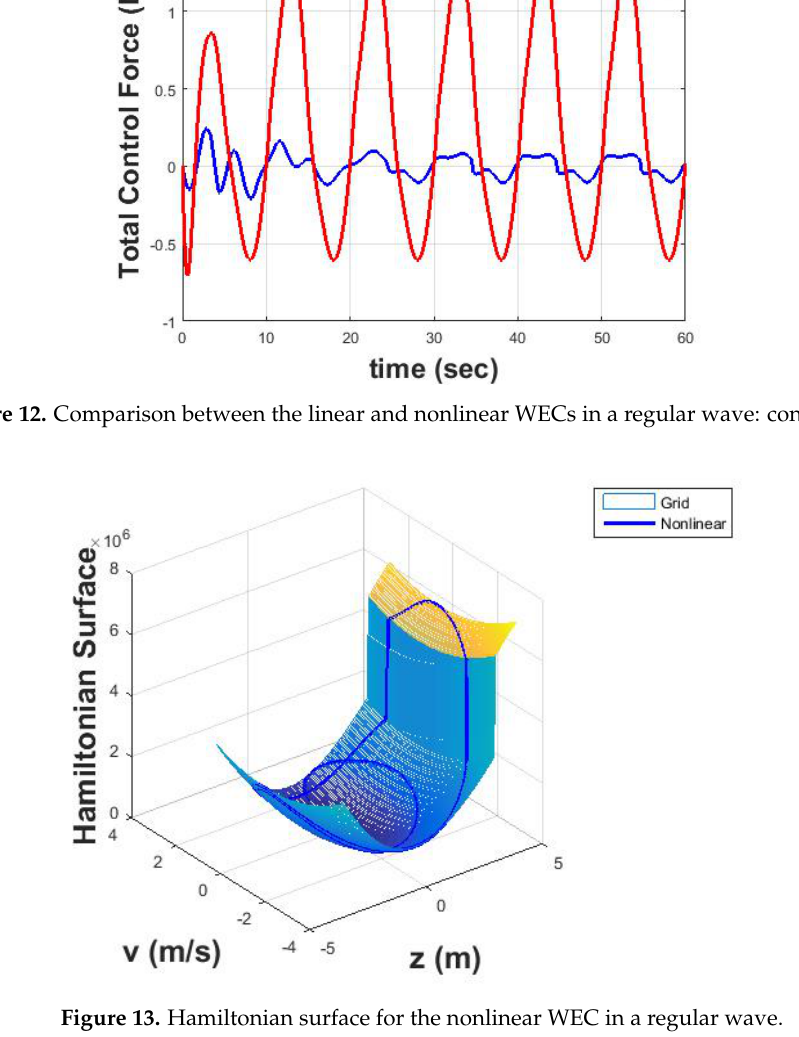
Figure 13. Hamiltonian surface for the nonlinear WEC in a regular